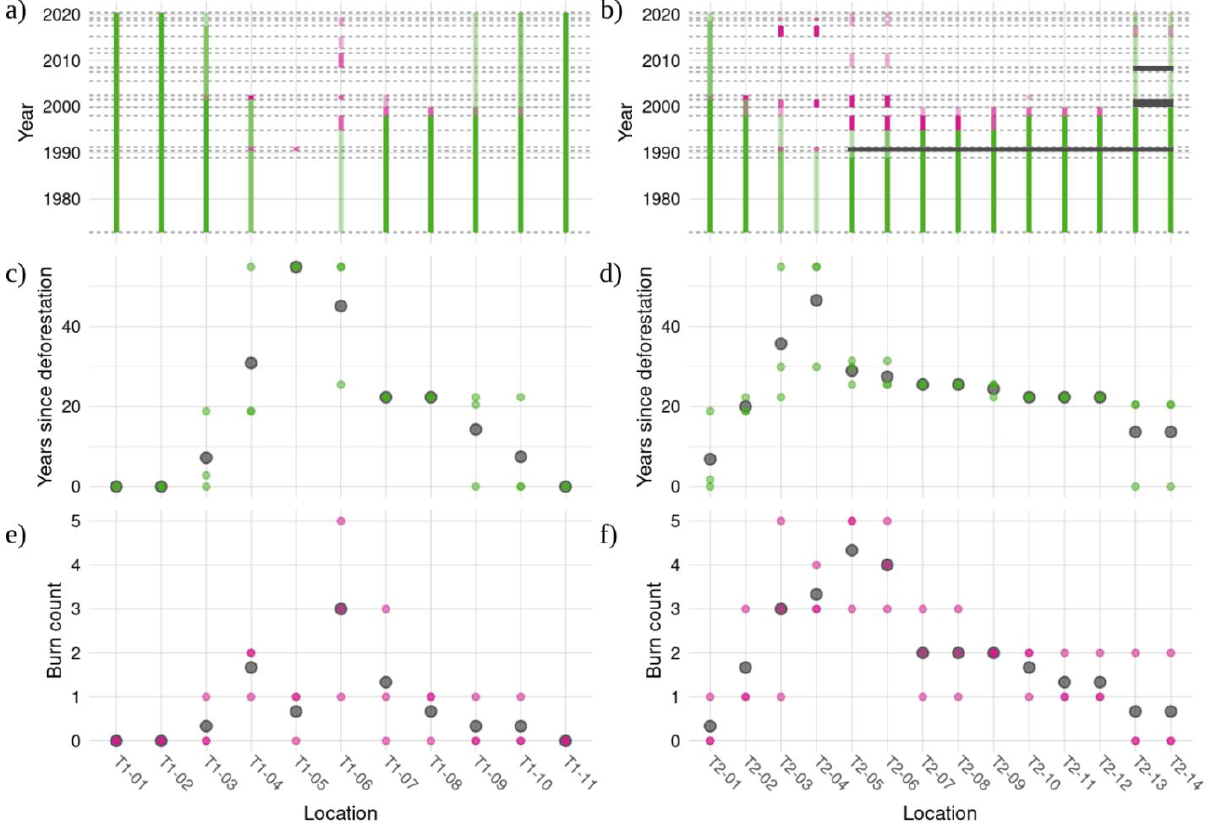
Figure A1. Fire occurrence and forest loss at Badas. (a, b) Scoring of each sample location on transects 1 (a) and 2 (b) as forest (dark green) or burned (red), vs. open land, based on Landsat images (imagery dates indicated by dashed horizontal lines). Data gaps due to cloud cover or the scan line detector failure on Landsat 7 are marked with gray boxes. Opacity indicates the proportion of scorers designating the location as forest or burned. (c, d) Years since deforestation of each sample location on transect 1 (c) and 2 (d) based on scoring (means: black points; individual scores: small green points). Locations scored as open in the first Landsat image (1972-10-15) were assumed to have been cleared on 1965-07-01. (e, f) Number of Landsat images showing each sample location as burned according to scores (mean: black points; individual scores: small red points).